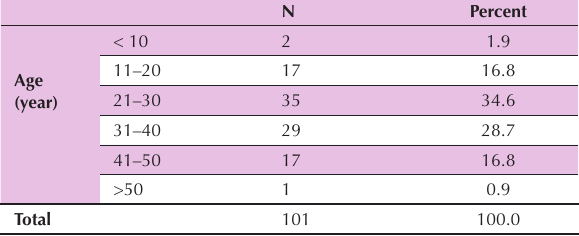
Table 2. Age of patients (by years) at the onset of clinical manifestations